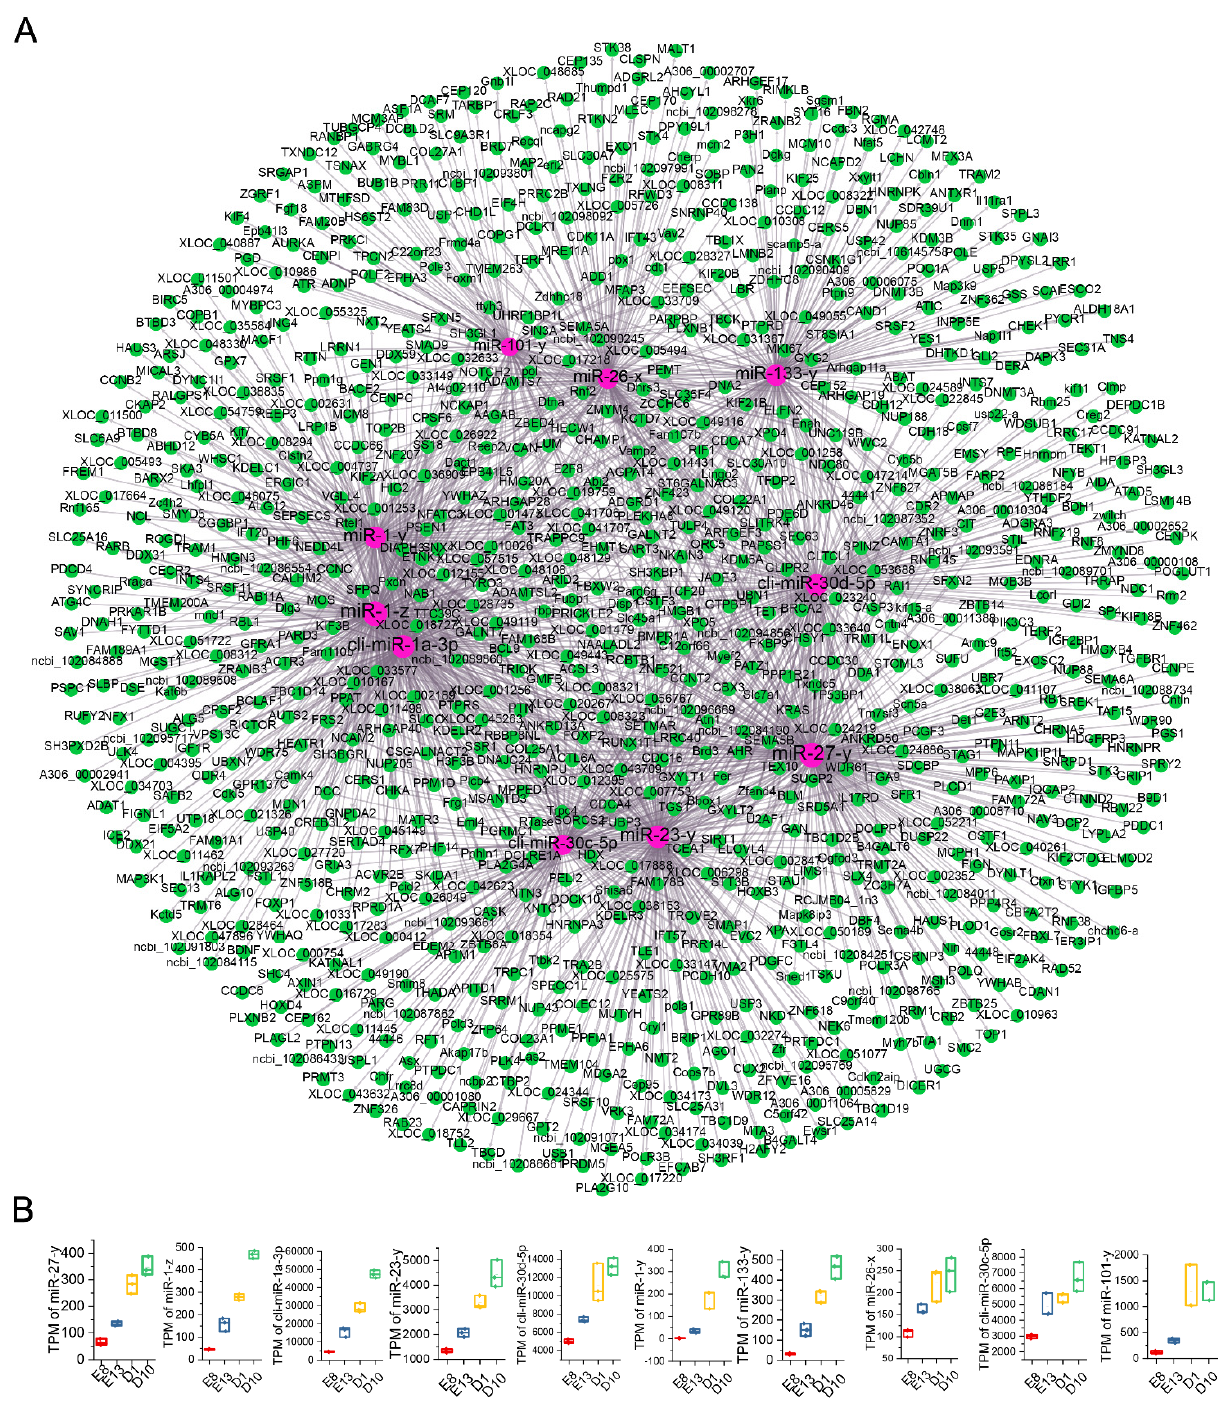
Figure 4. Identification and visualization of hub miRNAs in Network B. ( A ) Visualization of interactions between hub miRNAs and their target genes in Network B. The red node represents miRNA, the green node represents mRNA, and the node’s size represents degree, respectively. ( B ) The expression patterns of the ten hub miRNAs during the growth and development of pigeon skeletal muscle. The expression of all ten hub miRNAs was significantly upregulated during the growth stage.